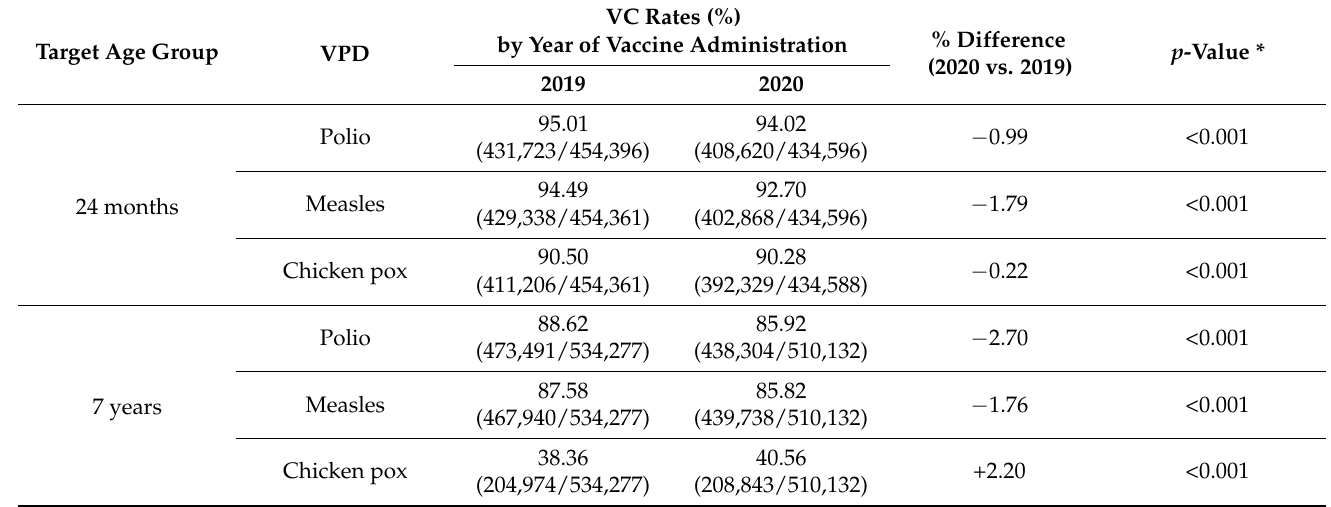
Table 1. National vaccine coverage (VC) rates (%) registered for mandatory vaccinations, plus chicken pox at 24 months and 7 years of age, stratified by vaccine type and year of administration, along with the percentage differences between the 2019 and 2020 rates in